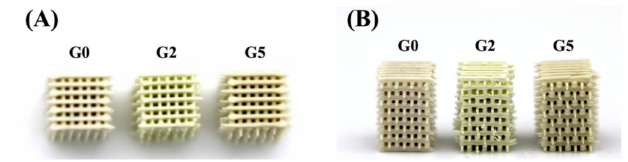
Figure 1. ( A ) The top view and ( B ) side view photographs of the GR-contained MSCS scaffolds.